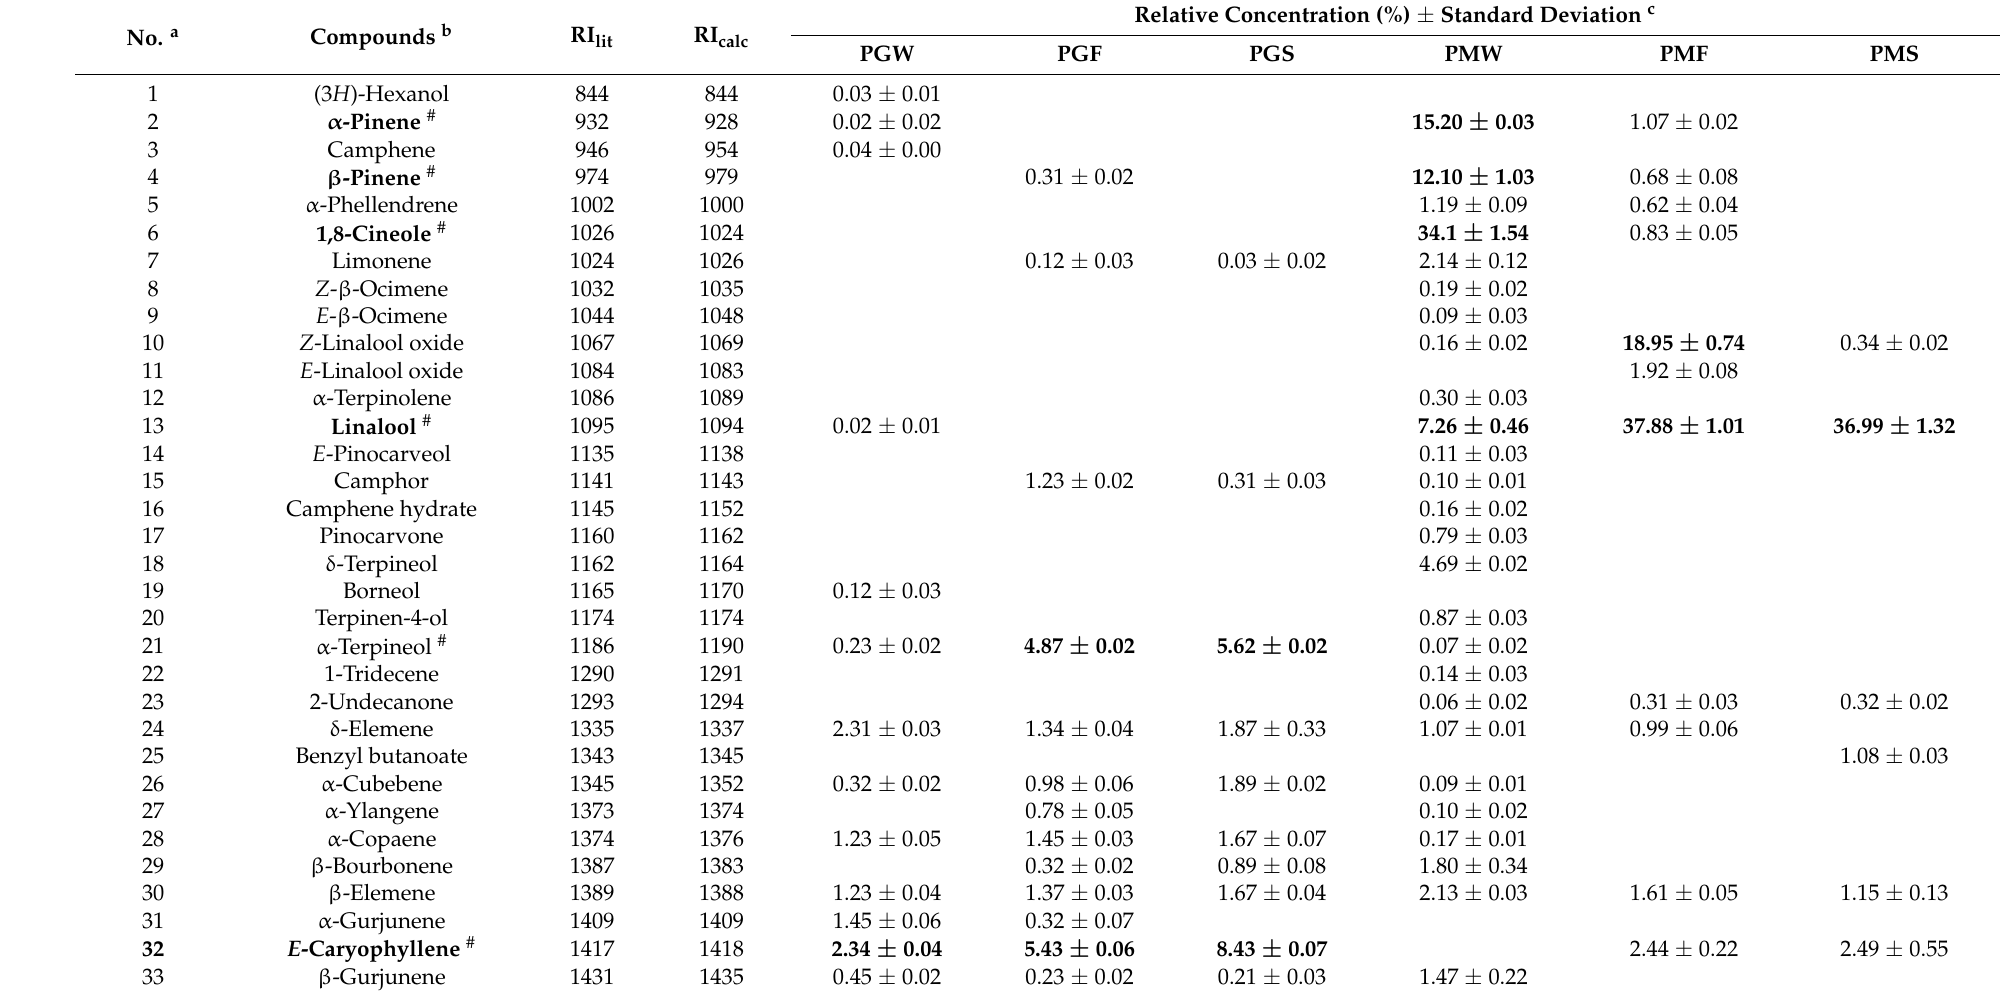
Table 1. Results of the analysis of essential oils from Piper mollicomum (PM), referred to as wild, first- and second-generation cultivars (PMW, PMF and PMS, respectively), and Piper gaudichaudianum (PG) referred to as wild, first- and second-generation cultivars (PGW, PGF and PGS,